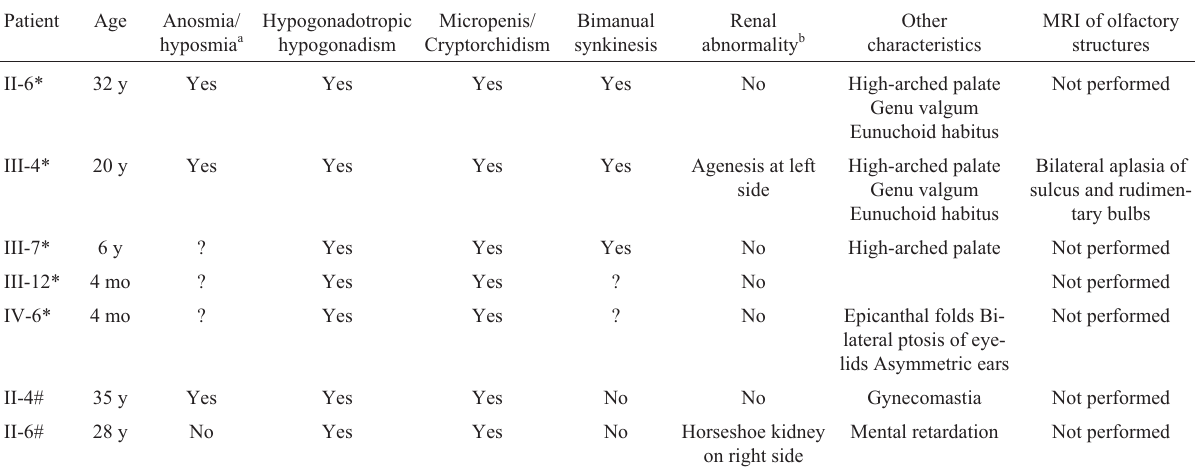
Table 1 - Clinical features of evaluated patients from families 1 and 2 with X-linked